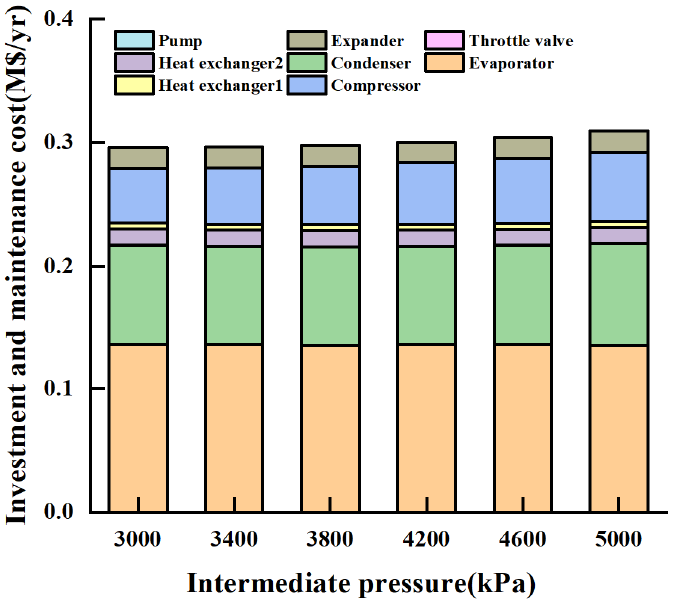
Figure 10. The capital input and maintenance cost of each component of the coupling system varied with the intermediate pressure.